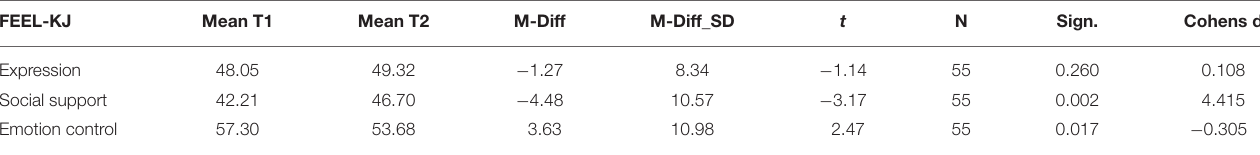
TABLE 4 | FEEL-KJ additional